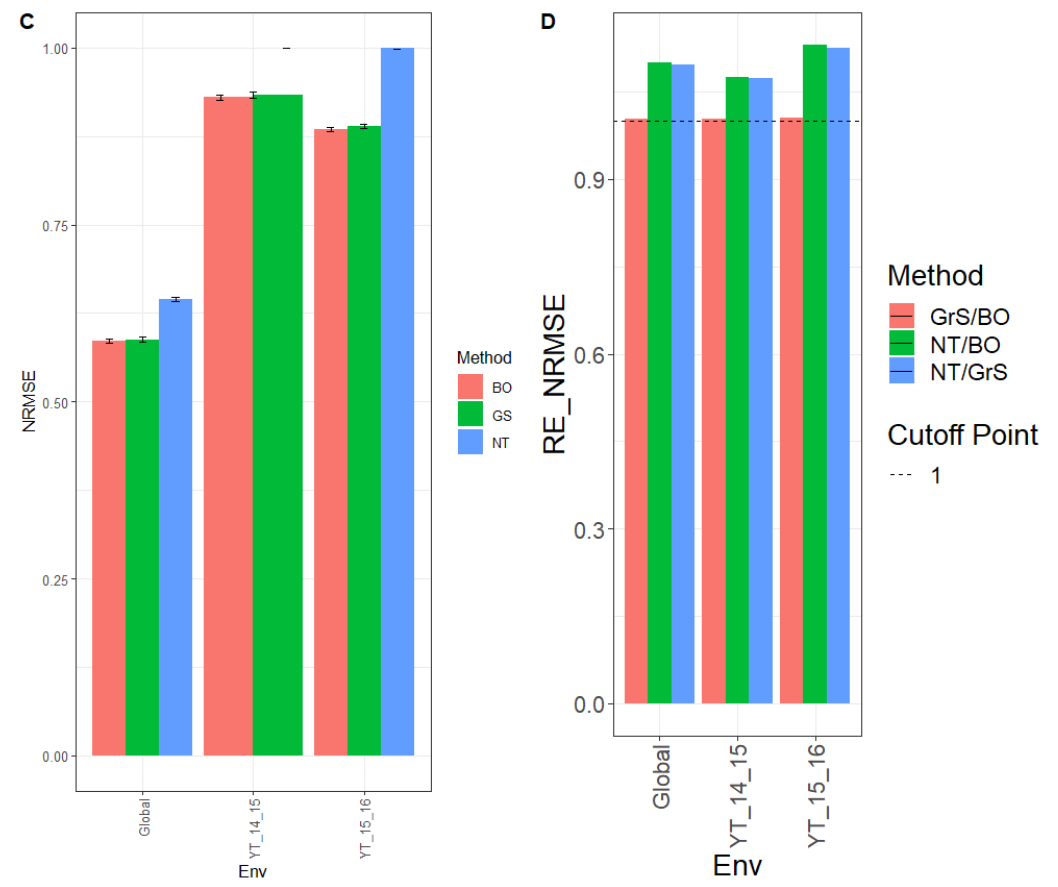
Figure 2. Dataset 2 (Wheat 2). A ) Mean squared error (MSE) and the corresponding standard error (SE) of the methods Bayesian optimization (BO), grid search optimization (GrS), and no tuning (NT) for each environ- ment and across environments of dataset 2. B ) Relative efficiency in terms of the mean squared error (RE_MSE) computed by dividing the MSE of NT and BO; NT and GrS; or GrS and BO. Prediction performance is reported for each environment and across environments in the dataset 2. When RE_MSE>1 the denominator method outperforms the numerator in terms of prediction performance. C ) Normalized root mean squared error (NRMSE) and the corresponding standard error (SE) of the methods Bayesian optimization (BO), grid search optimization (GrS), and no tuning (NT) for each environment and across environments of dataset 2. D ) Rela- tive efficiency in terms of the normalized mean squared error (RE_NRMSE) computed by dividing the NRMSE of NT and BO; NT and GrS; or GrS and BO. Prediction performance is reported for each environment and across environments in dataset 2. When RE_NRMSE>1 the denominator method outperforms the numerator in terms of prediction